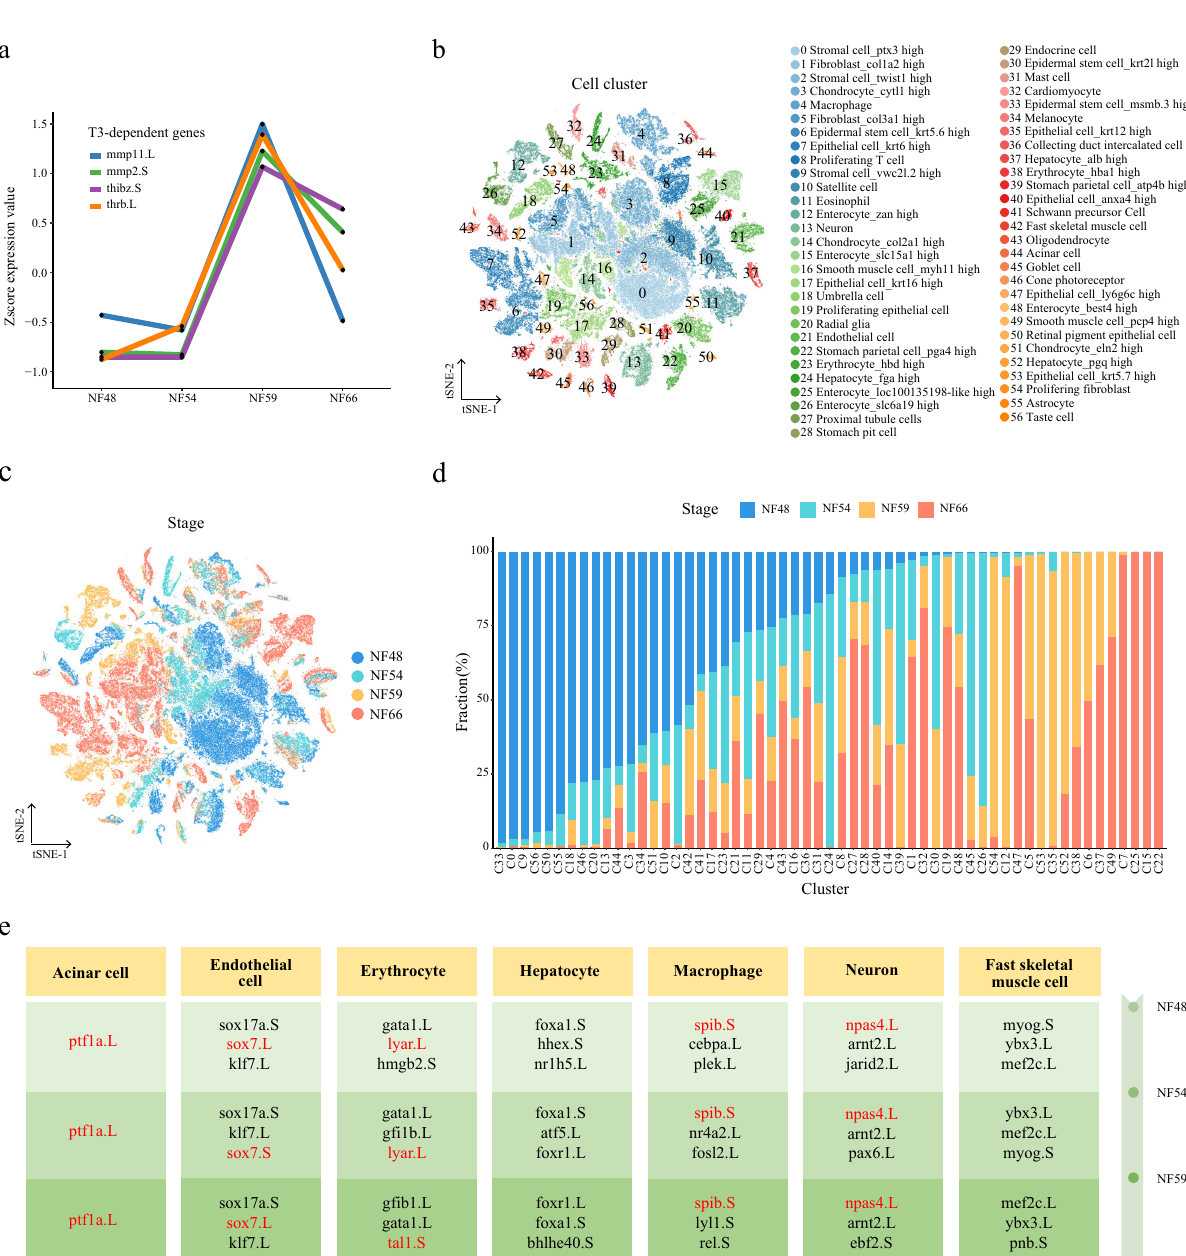
Fig. 4 Cell landscape of larval Xenopus during metamorphosis. a Expression trajectory of genes regulated by T3 during metamorphosis. b , t-SNE analysis of 188, 020 single cells collected from larval Xenopus . 57 cell-type clusters are labeled in different colors. Cell cluster markers are listed in Supplementary Dataset 1. c t-SNE analysis of 188, 020 single cells collected from larval Xenopus . Stages are labeled in different colors. d Stage proportion in different cell clusters. Stages are labeled in different colors. e dTFs are listed in different stages for cell lineages. Each row represents one stage and each column represents one cell type. The representative TFs for each cell types are labeled by red.